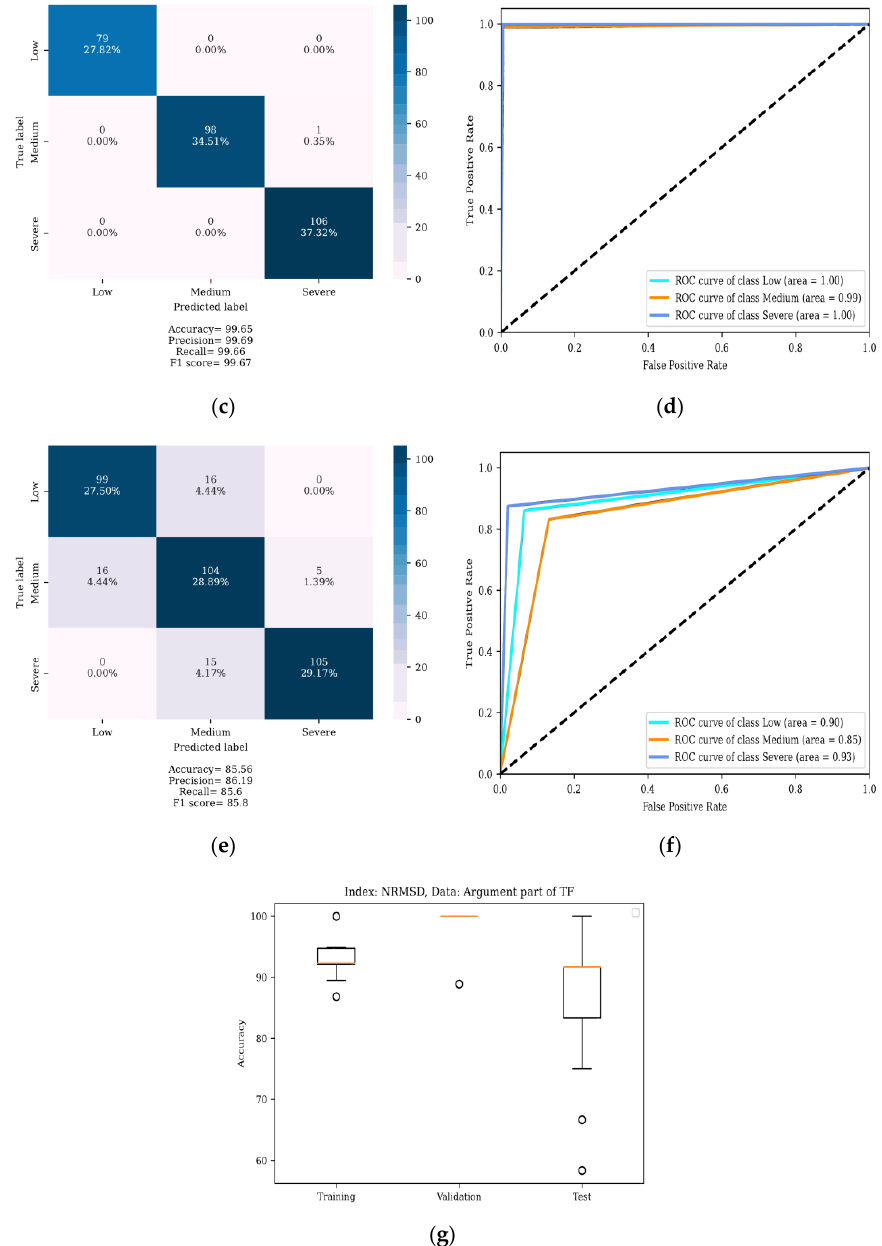
Figure 27. GMDH performance in determining the severity of the DSV fault using the extracted features from the phase part of the TF using NRMSD index: ( a ) training confusion matrix; ( b ) training ROC curve; ( c ) validation confusion matrix; ( d ) validation ROC curve; ( e ) test confusion matrix; ( f ) test ROC curve; ( g ) box plot of the training, validation, and test accuracies in thirty iterations With regard to determining DSV severity, the MLP model is trained with an average accuracy of 99.14%. The average validation and test accuracies are 98.23% and 91.39%, respectively. In the box plot of the test accuracies, the maximum value is 100%, and the minimum value is close to 85%. The lower and upper quartiles are close to 90% and 100%, respectively. The GMDH model is trained with an average accuracy of 93.17%. The average validation and test accuracies are 99.65% and 85.56%, respectively. In the box plot of the test accuracies, the maximum value is 100%, and the minimum value is close to 75%. The lower and upper quartiles are close to 80% and 90%, respectively. Therefore, both GMDH and MLP models can determine the severity of the DSV fault with a maximum test accuracy of 100%. In the box plot of test accuracies, minimum, lower, and upper quartile values of the MLP model are 10% above the GMDH